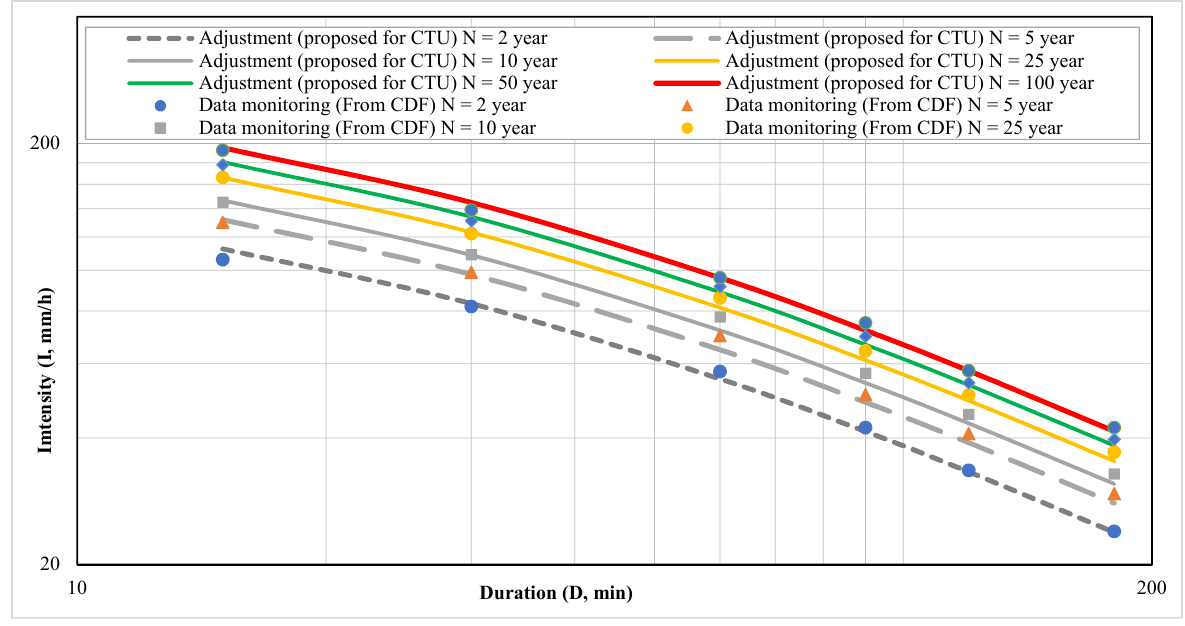
Figure 12. Proposed IDF rainfall curve for Can Tho city. IDF curve proposed for Can Tho City with parameter modification, and IDF curve built from monitoring rainfall data of Can Tho City.